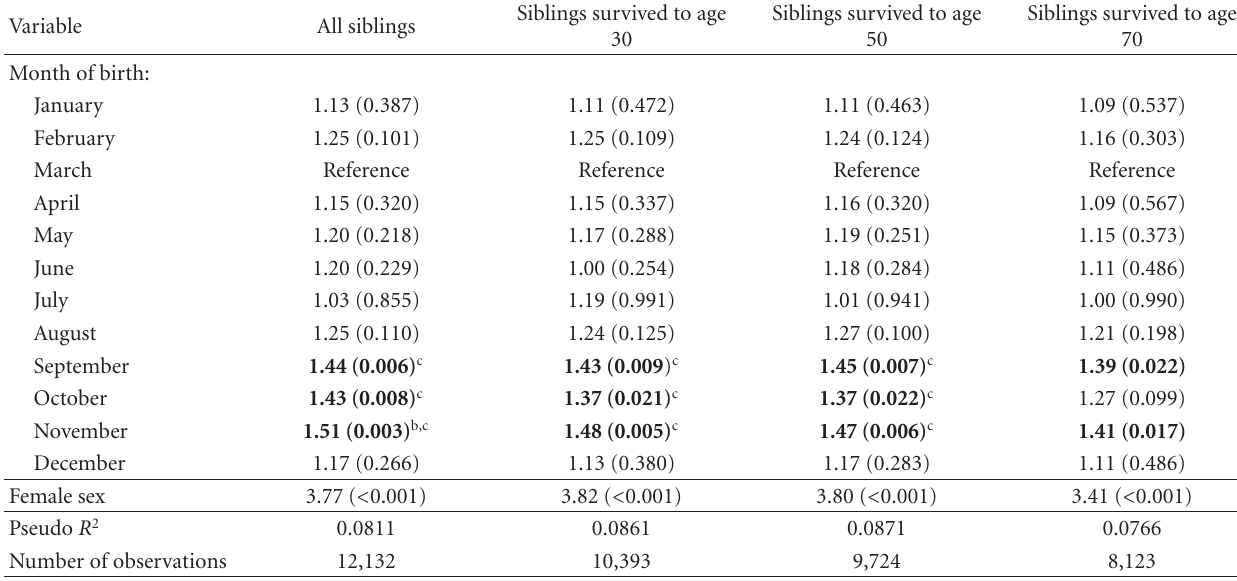
Table 5: Odds ratios ( P values) to become a centenarian as predicted by conditional logistic regression (fixed e ff ects) for di ff erent age cut-o ff subgroups. E ff ects of month of birth a